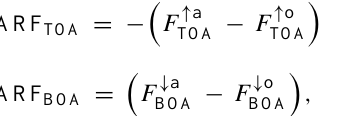
Moscow (a) and the SSA difference (dSSA) between Moscow and Zvenigorod (b) .